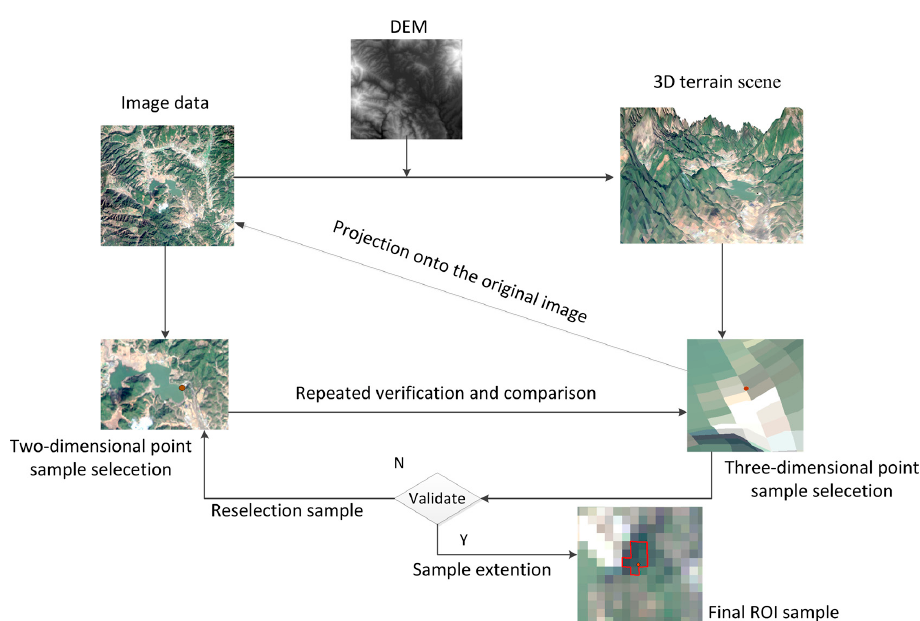
Figure 3. The flow chart of 3D terrain-aided ROI selection.